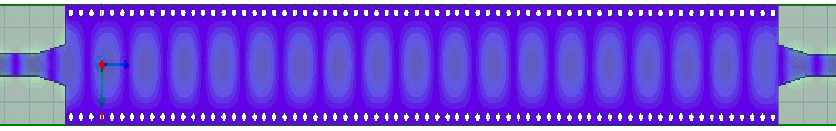
Figure 3. Parametric analysis for the length of parallel longitudinal slots of SIW LWA.